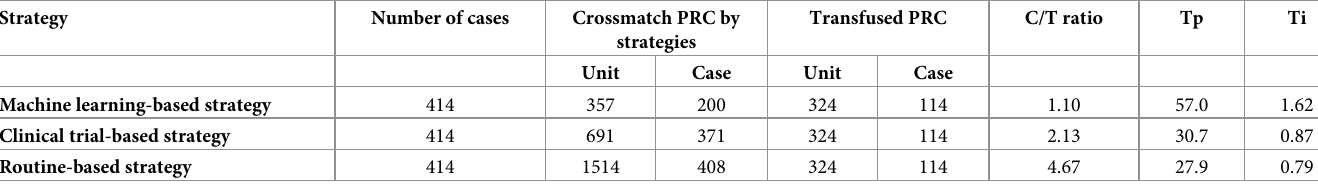
Table 4. Crossmatch to transfusion ratio, transfusion probability, transfusion index of packed red cell. Strategy